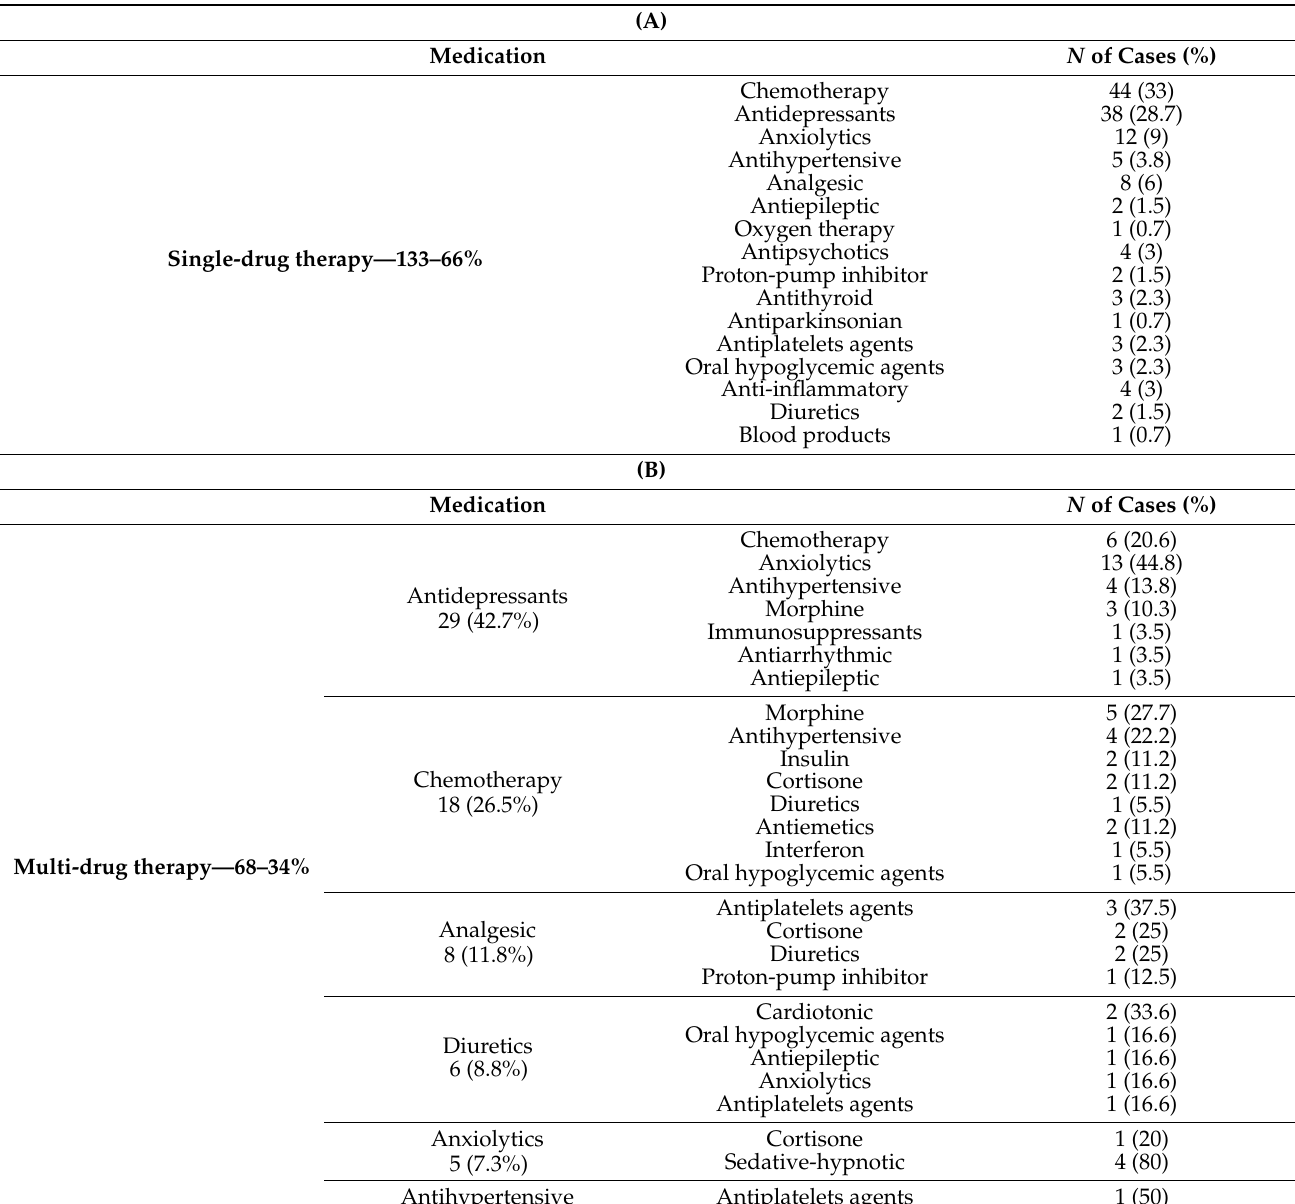
Table 3. Medications taken by the enrolled victims. In A, details of single-drug therapy; in B, details of multi-drug